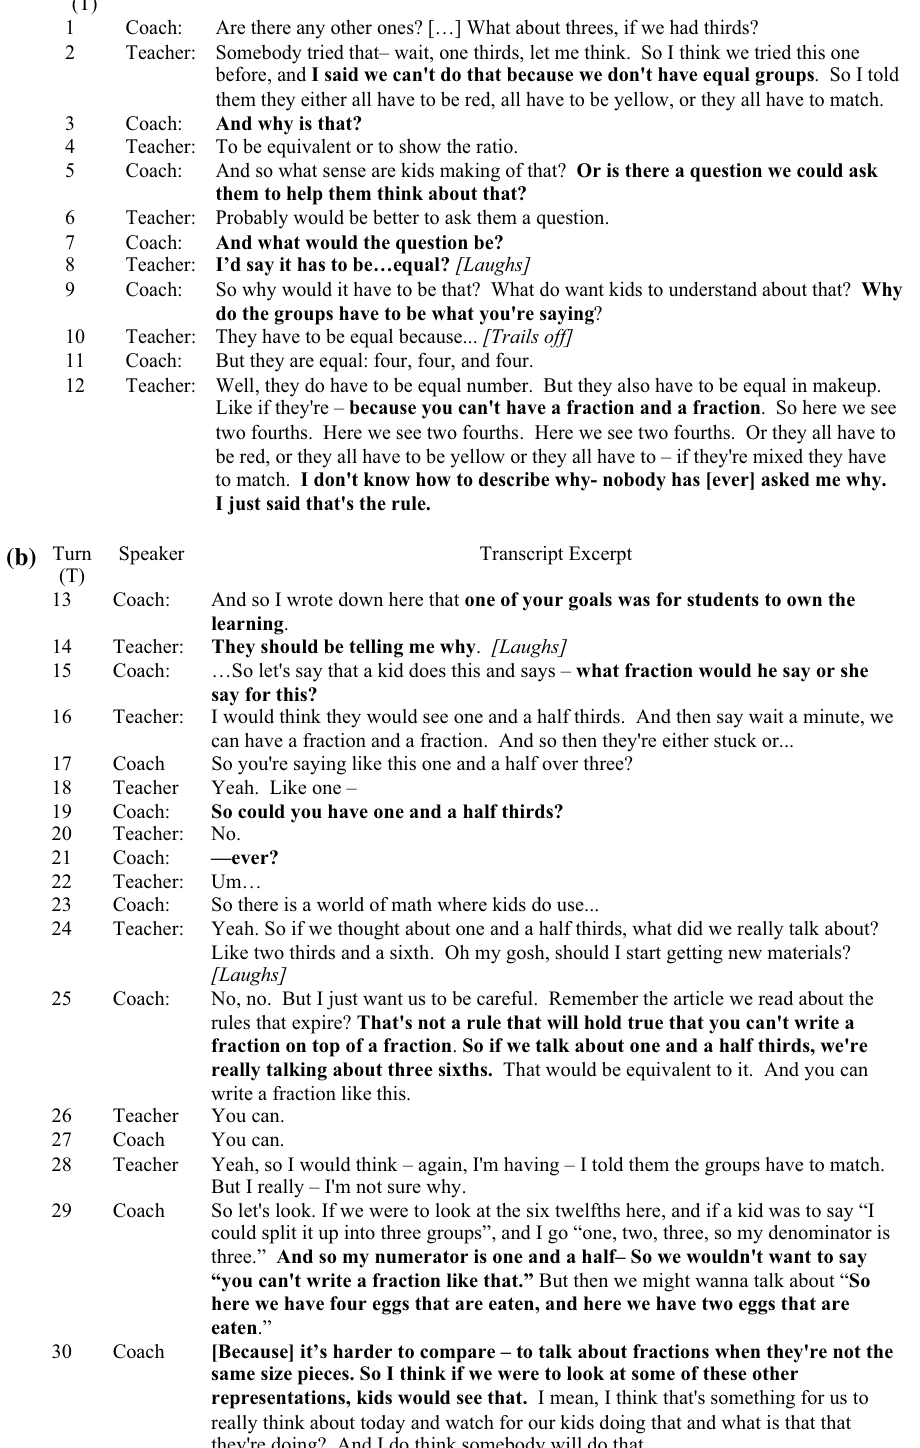
Fig. 5 a Excerpt highlighting high-growth theme 2. b Excerpt illustrating high-growth theme